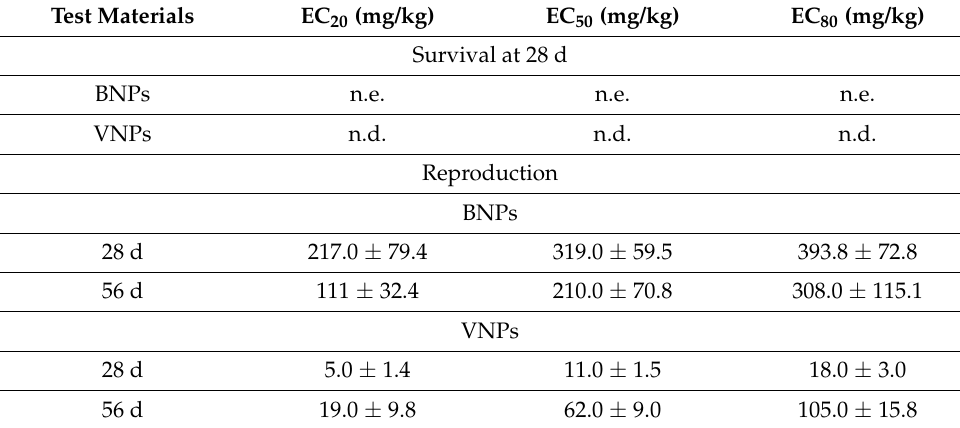
The calculated BNPs EC x for reproduction were lower at 56 d comparing with 28 d, whereas, for VNPs, an opposite pattern was found: EC x at 56 d were higher than ECx at 28 d (Table 2). With the extension of the exposure time, for BNPs, effects on the